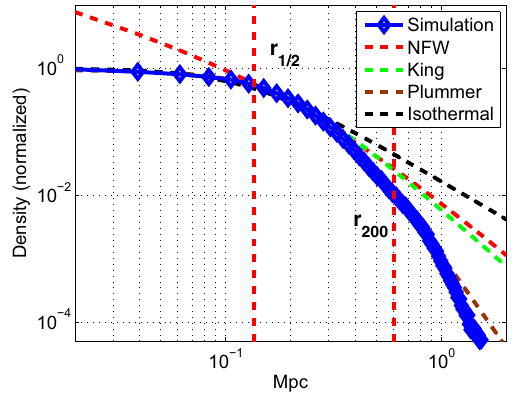
Fig. 1 The initial mass profile of SIDM halos used in this work, blue diamonds , is the Plummer density shown with brown dashed line. Also shown is the approximate King model’s profile used in [23,30], green dash-dotted line . NFW profile [51] ( red dashed line ) and the isothermal profile [50] ( black dashed line , ρ( r ) = ρ 0 /( 1 + r 2 / r 2 c ) ) are also shown for reference. The profile’s 1/2-level half-width and the virial radius are indicated with labels r 1 / 2 and r 200 ,